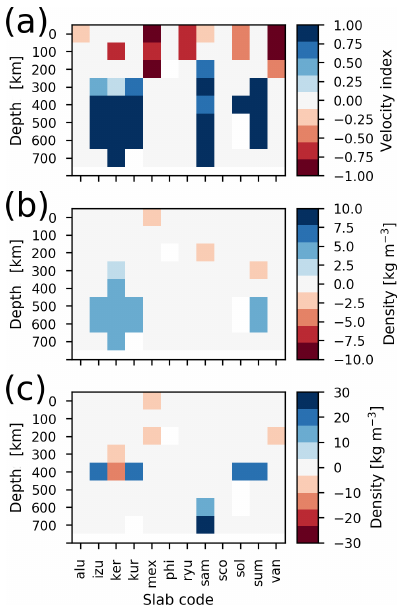
Figure 8. Comparison with Slab1.0 (Hayes et al., 2012). The slab codes stand for the following: alu – Alaska–Aleutians; izu